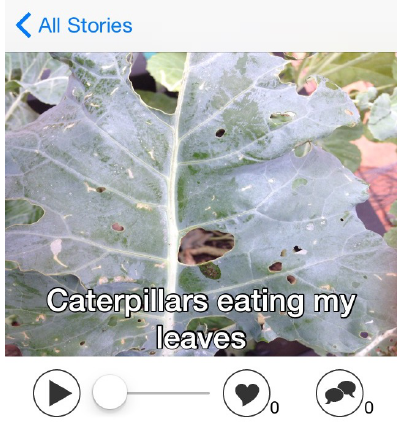
Figure 6. An image from P2’s story of a cauliflower plant raided by